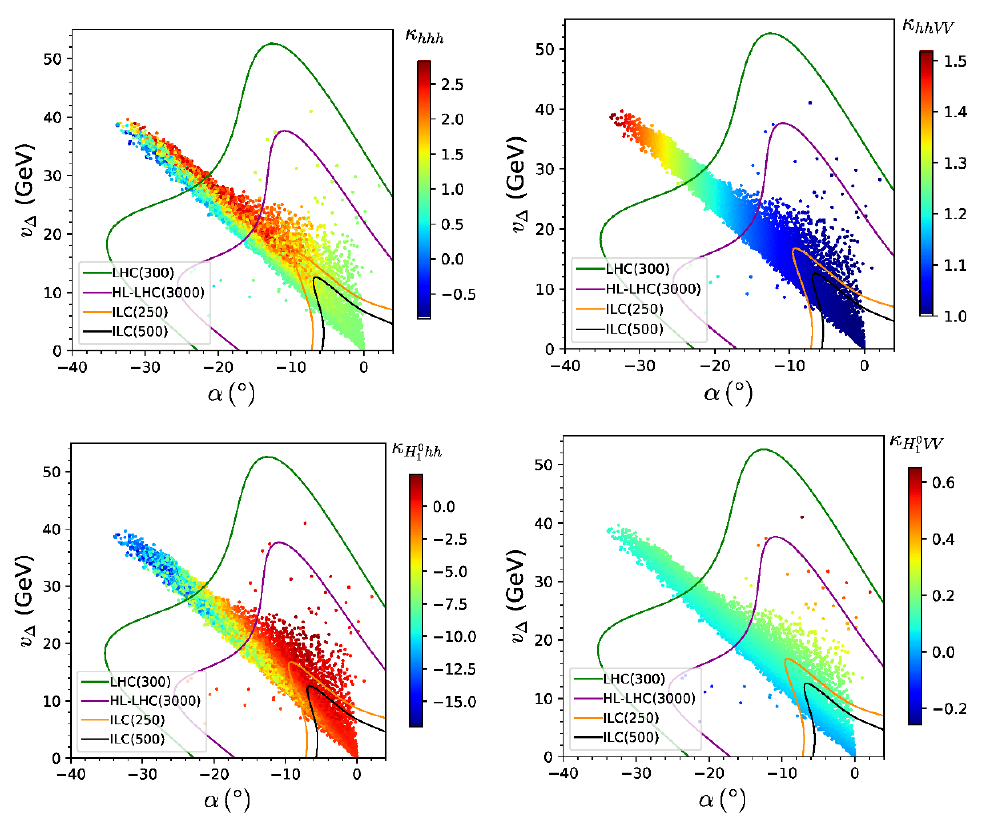
Figure 13 . Same as (cid:12)gure 11, but for (cid:20)